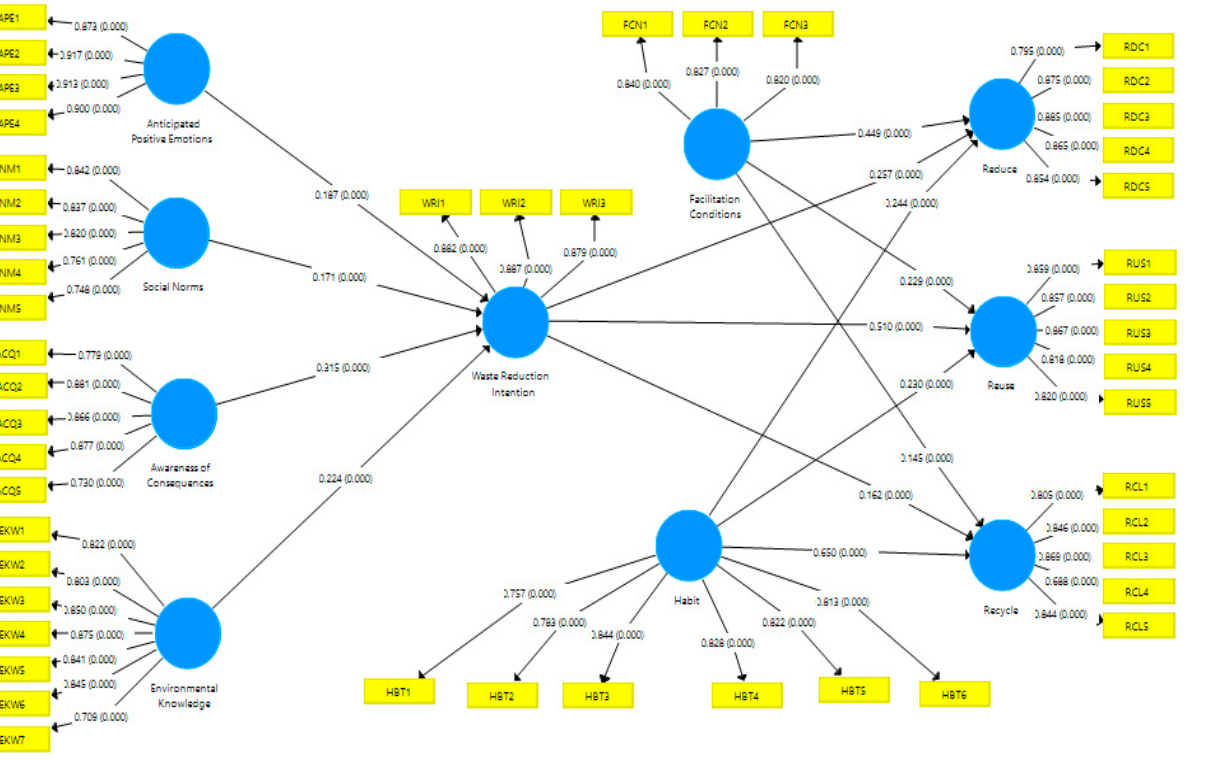
Figure 2. Structural Model